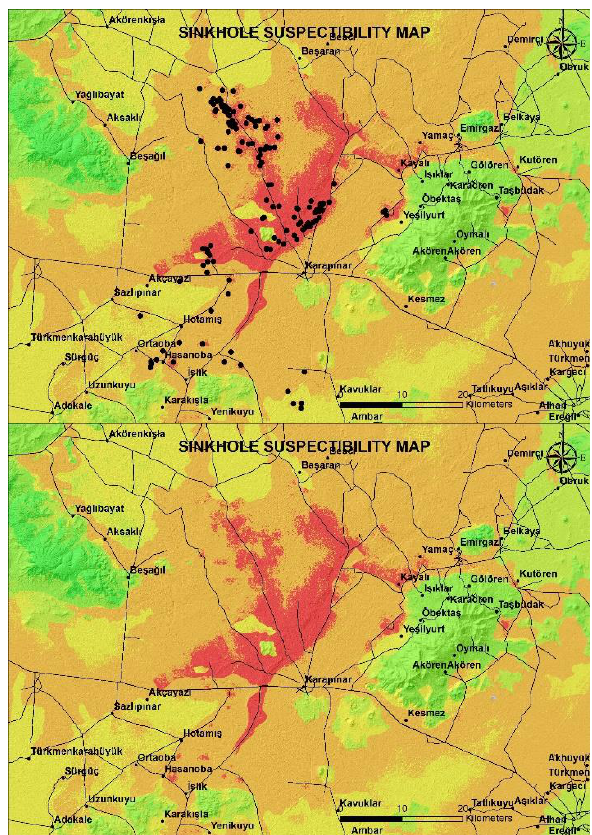
Figure 5. Susceptibility maps and intersections with existing